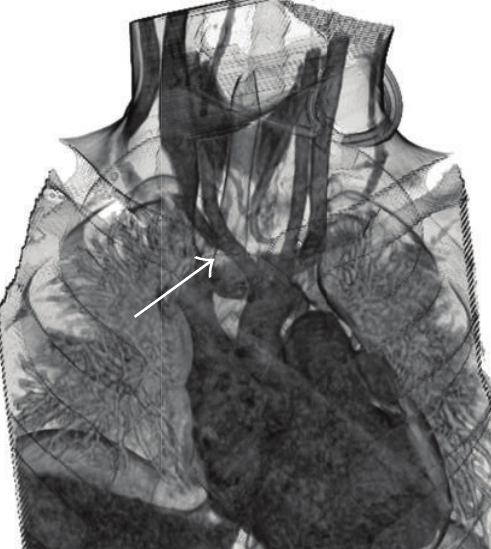
Figure 4: 3D CT. Three-dimensional CT shows the innominate artery (white arrow) crossing the trachea from left to right just cranial to the